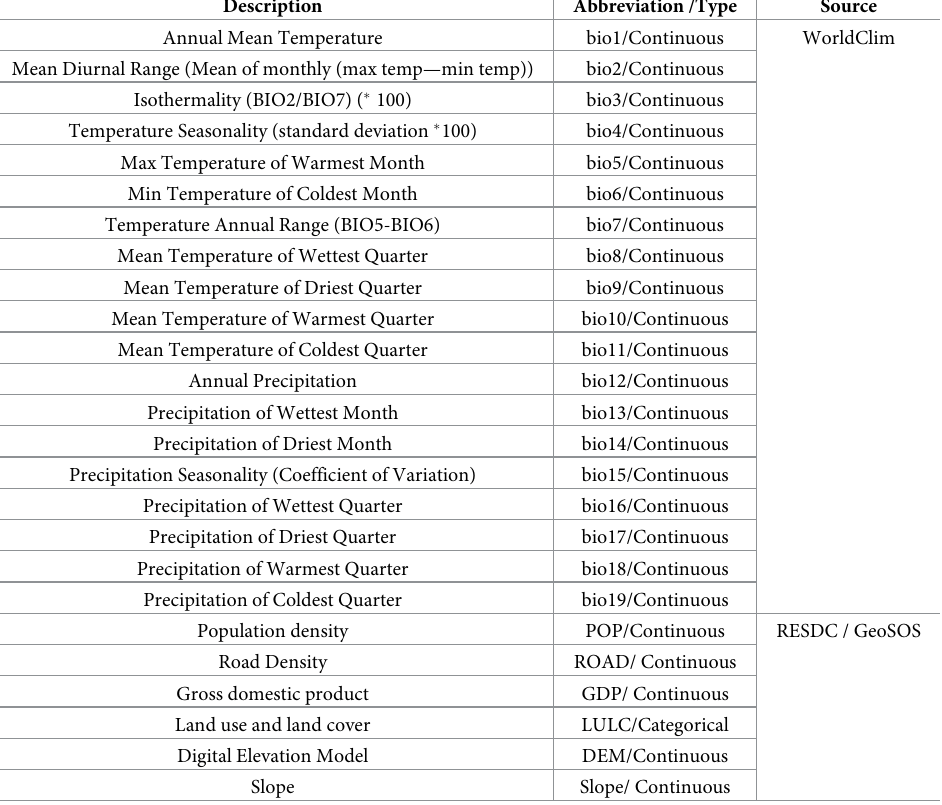
Table 1. Different types of data used in this